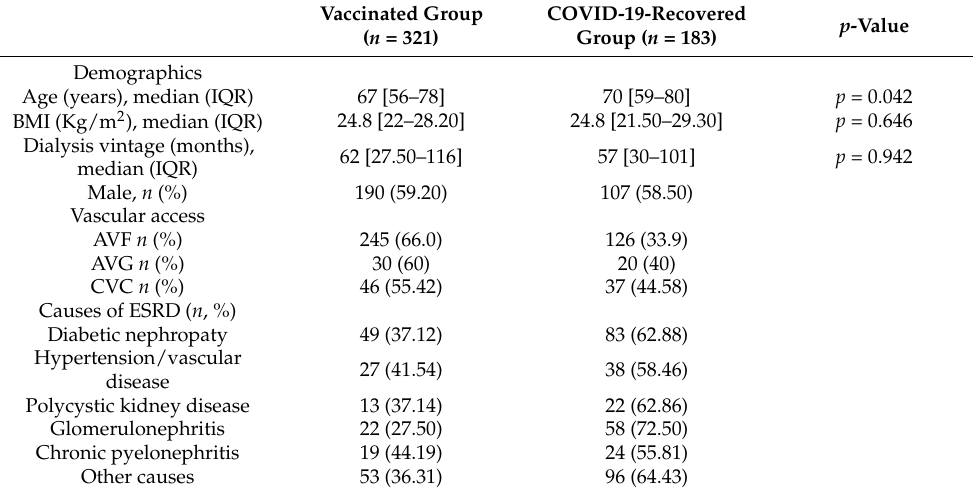
Table 1. Patient baseline characteristics of the vaccinated group and the COVID-19-recovered